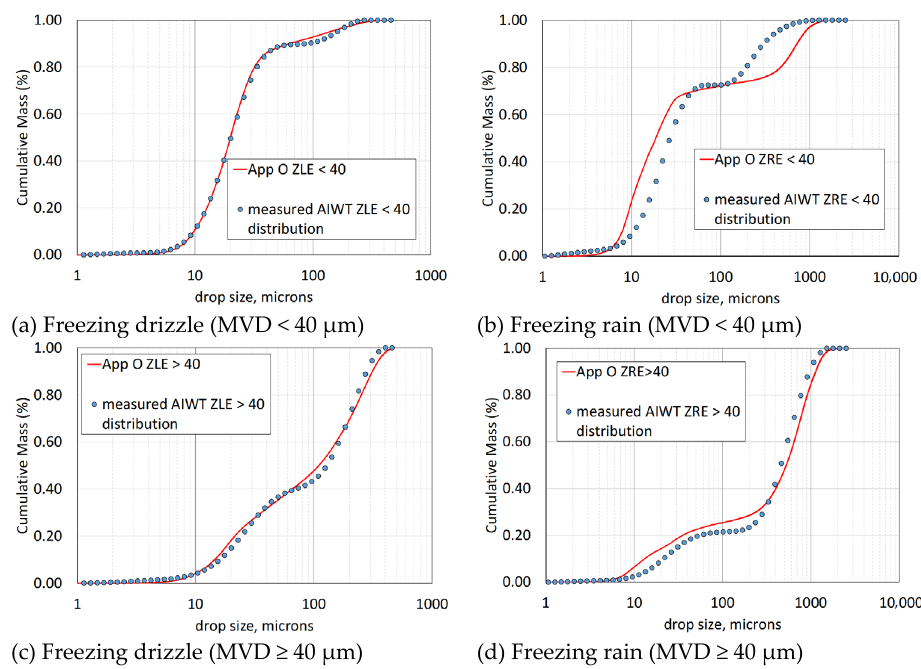
Figure 2. NRC − AIWT drop cumulative mass distribution for freezing drizzle and freezing rain.